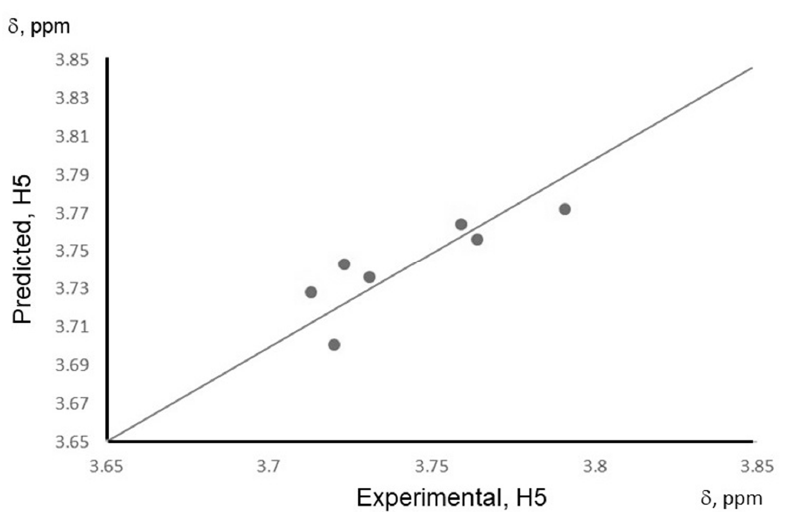
Figure 5. A correlation plot of experimental and predicted values of δ (H 5 ) based on the QSPR model for pure phenolic acids and their mixtures with β ‐ cyclodextrin.